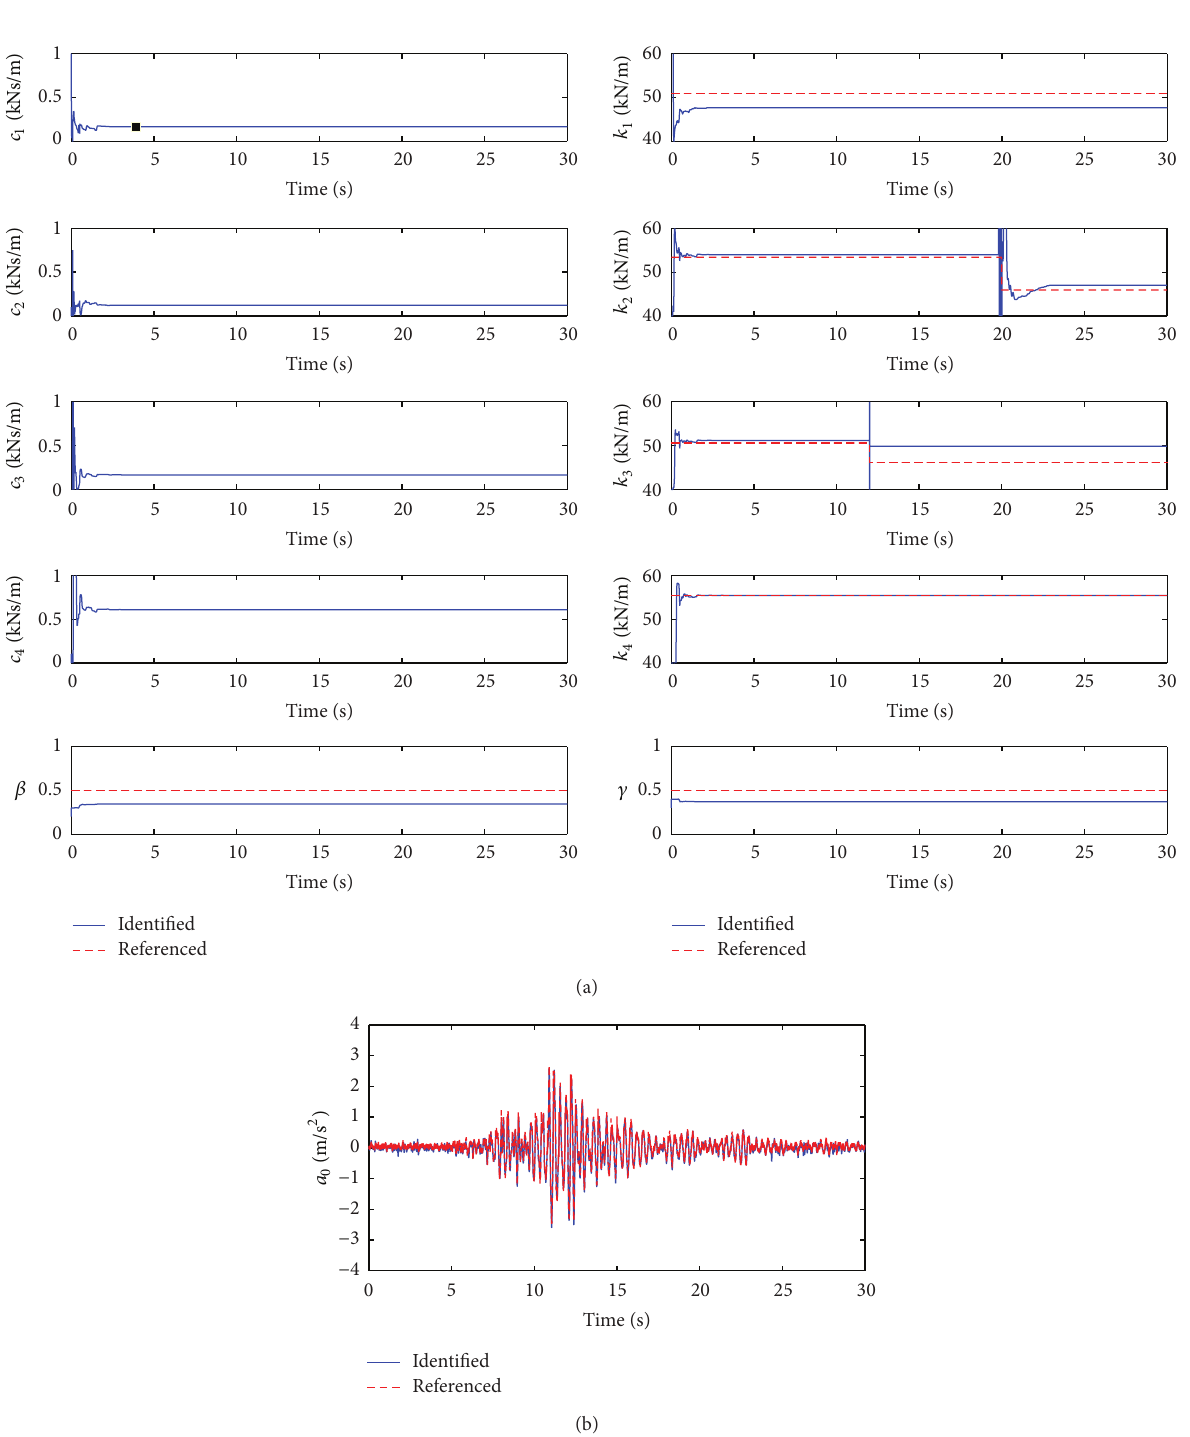
Figure 12: Identified results for Case 4: (a) identified parameters; (b) Identified